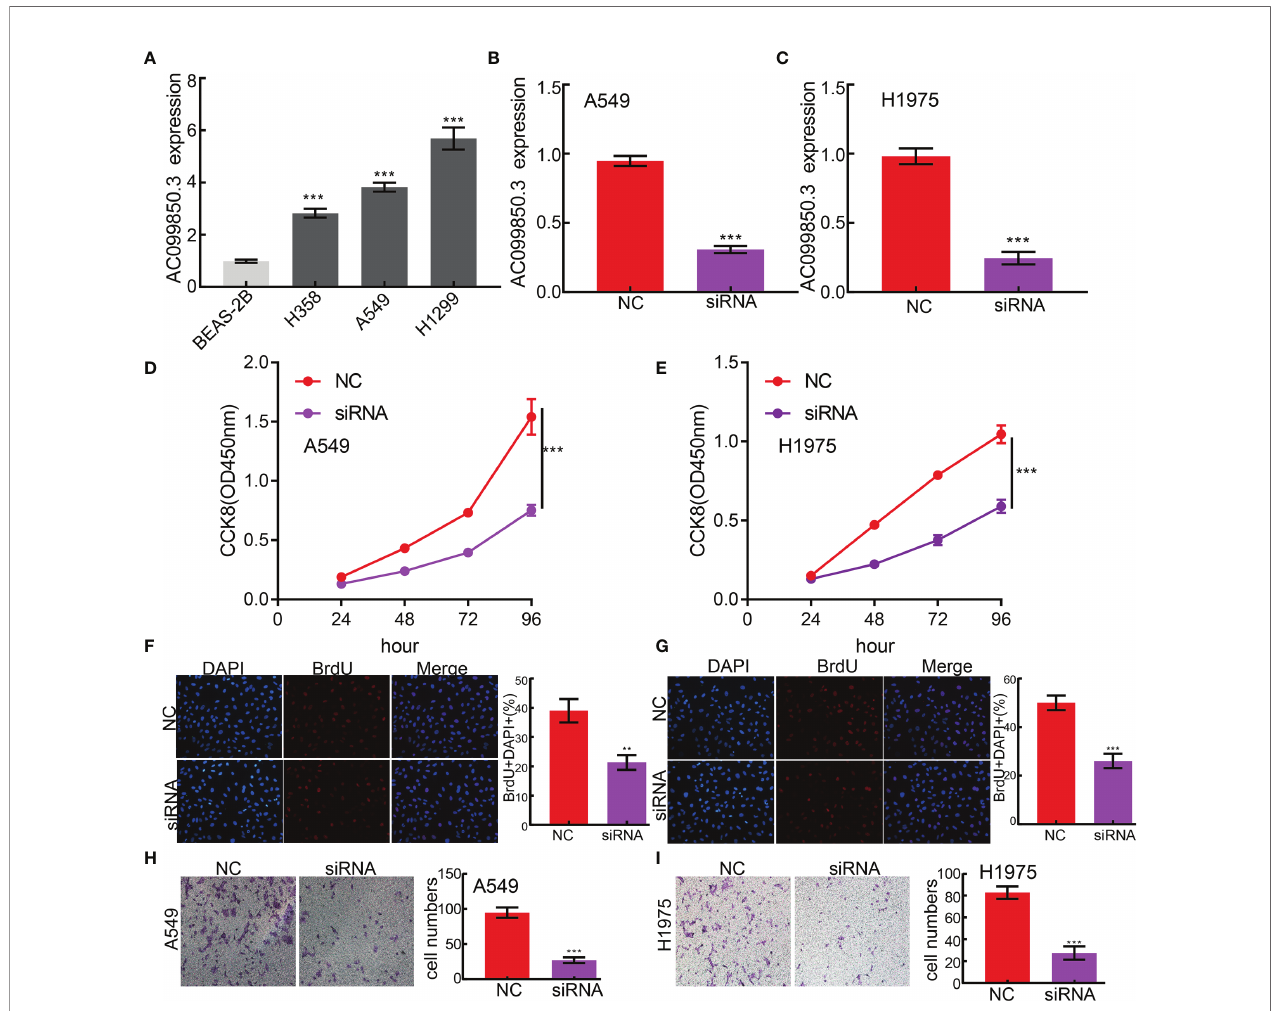
FIGURE 11 | lncRNA-AC099850.3 modulates LUAD cell proliferation and migration in vitro. (A) The relative expression level of AC099850.3 in LUAD cancerous cell lines, including H358, H1975, and A549, examined by real-time RT-PCR, compared to normal human bronchial epithelial cell line: BEAS-2B. (B, C) Establishment of AC099850.3 knockdown cell lines in A549 and H1975 veri fi ed by real-time RT-PCR (D – G) Knockdown of lncRNA AC099850.3 signi fi cantly inhibits cell proliferation as measured by CCK8 and BrdU assays. (H – I) Knockdown of lncRNA AC099850.3 dramatically inhibits LUAD cell migration ability examined by transwell assay. ***P<0.001. NC, negative control; siRNA = AC099850.3